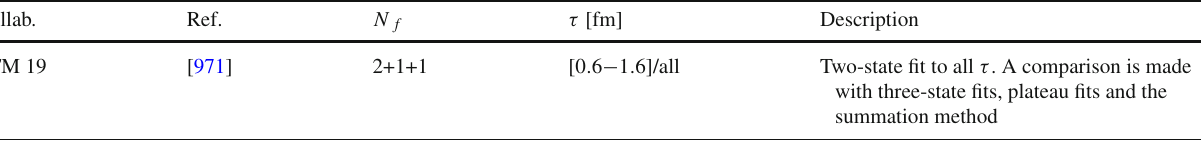
Table 193 Control of excited state contamination in direct determinations of σ π N and σ s . The comma-separated list of numbers in square brackets denote the range of source-sink separations τ (in fermi) at each value of the bare coupling. The range of τ for the connected (disconnected) contributions to the three-point correlation functions is given first (second). If a wide range of τ values is available this is indicated by “all” in the table Collab.